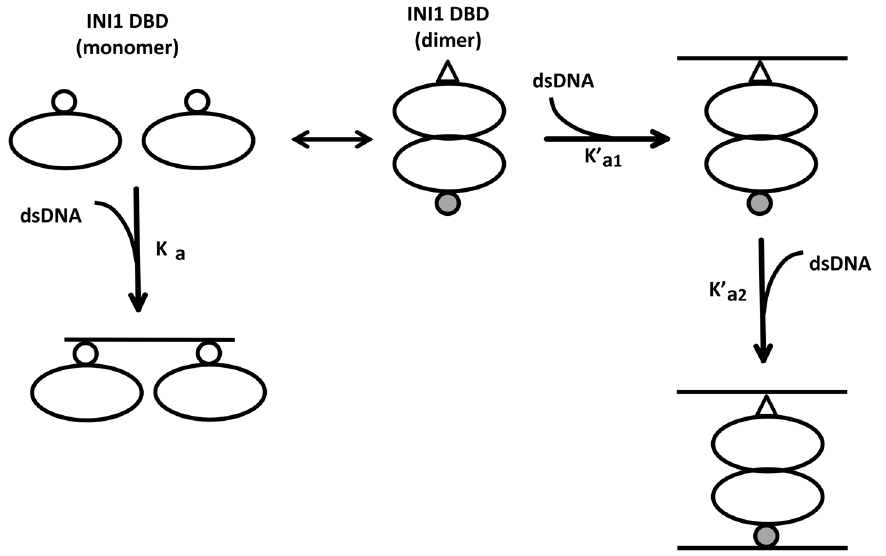
Figure 7. Model showing different modes of INI1 DNA binding. The INI1 DBD undergoes concentration dependent multimerization. Two molecules of monomeric DBD binds to one molecule of U5 HIV-1 LTR DNA whereas one molecule of dimeric DBD binds to two molecules of U5 HIV- 1 LTR DNA.